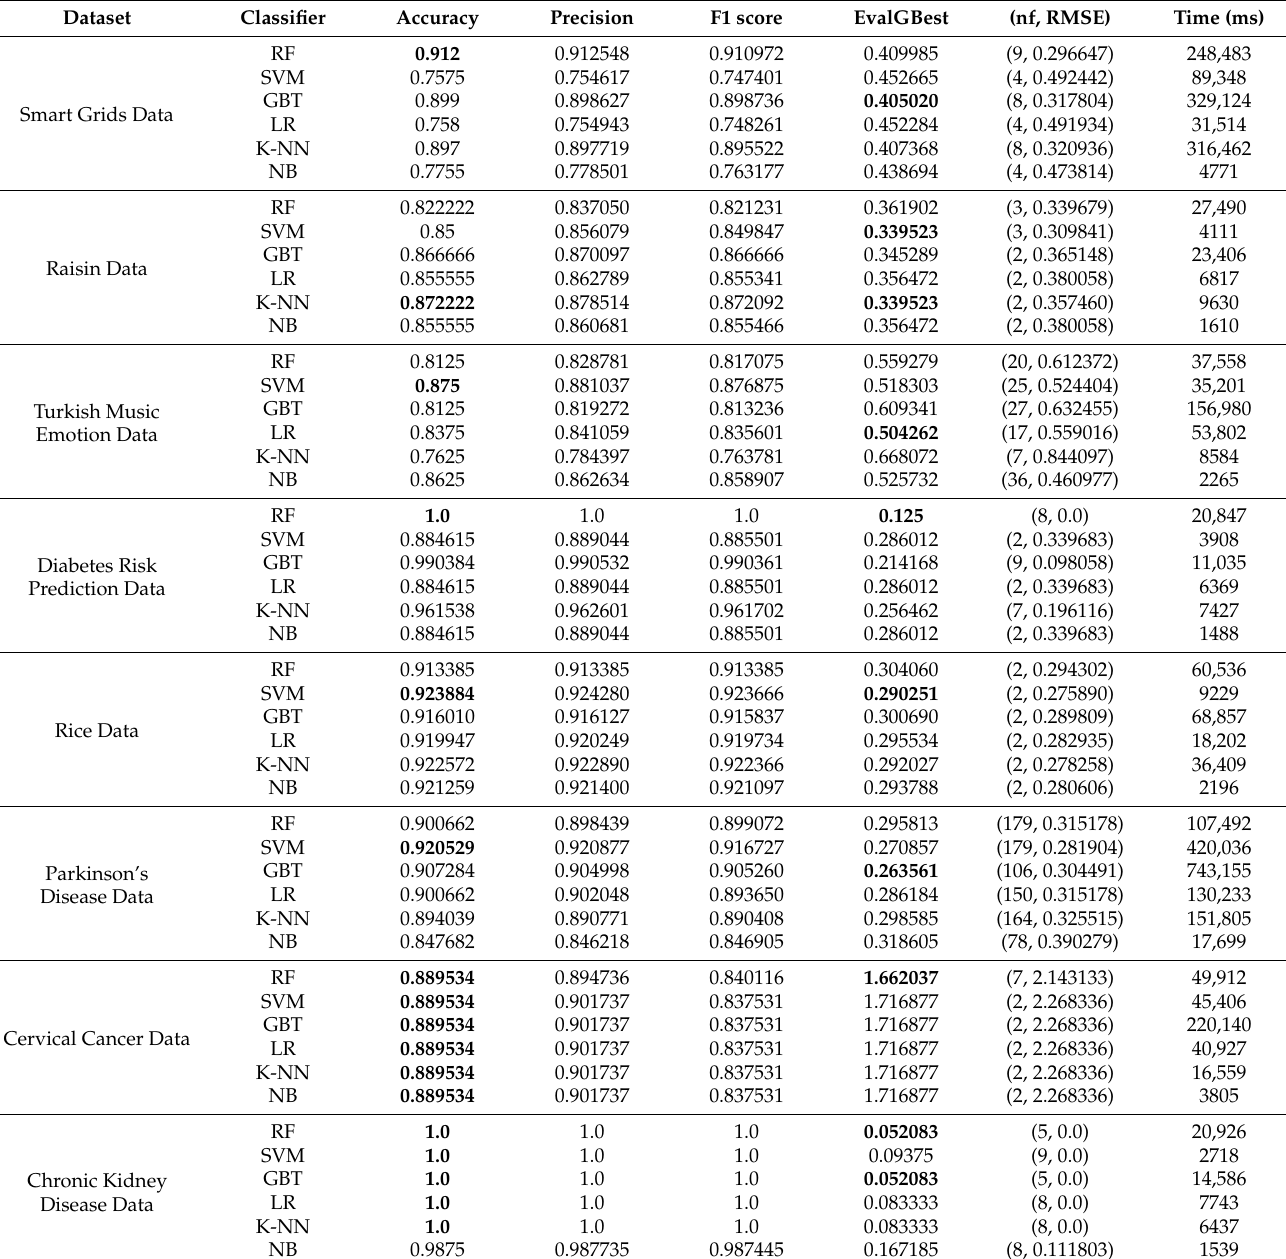
Table 10. BPSO Experimental Results